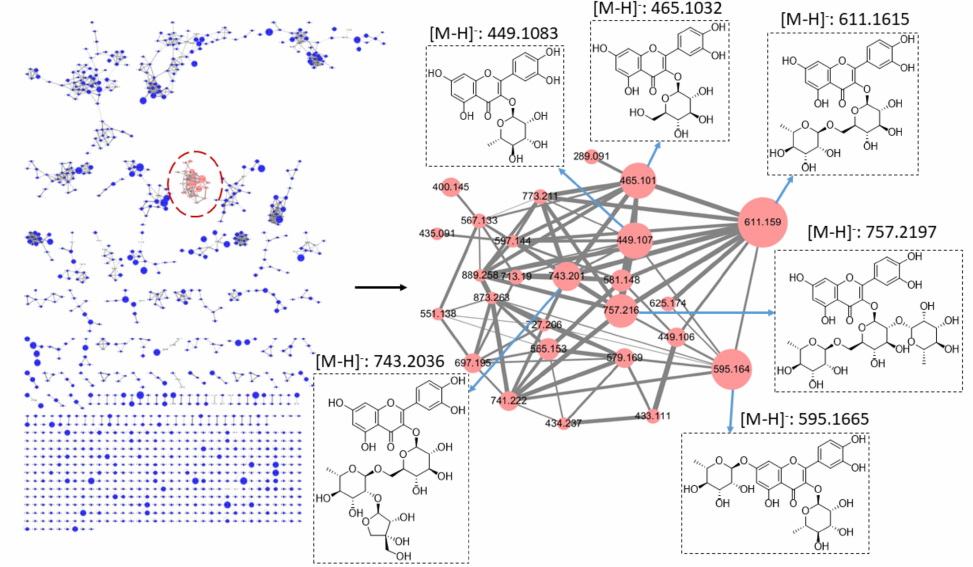
Figure 1. Molecular networking analysis of the BuOH soluble fraction of Djulis hull extract. Table 1. Six major metabolites in the Djulis hull extracts were annotated according to the GNPS library and their MS/MS spectra. Compound